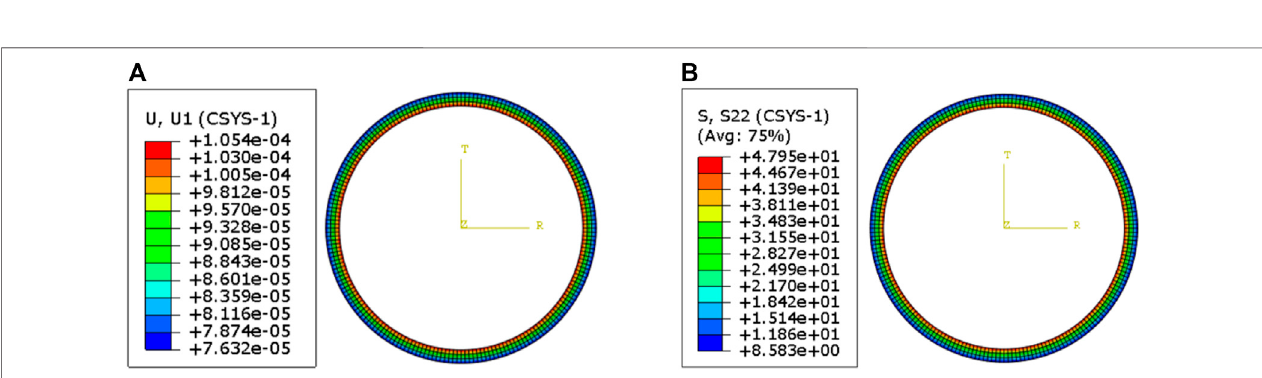
FIGURE 9 | Radial deformation and circumferential stress of shield lining. (A) Radial deformation of shield lining. (B) Circumferential stress of shield lining.